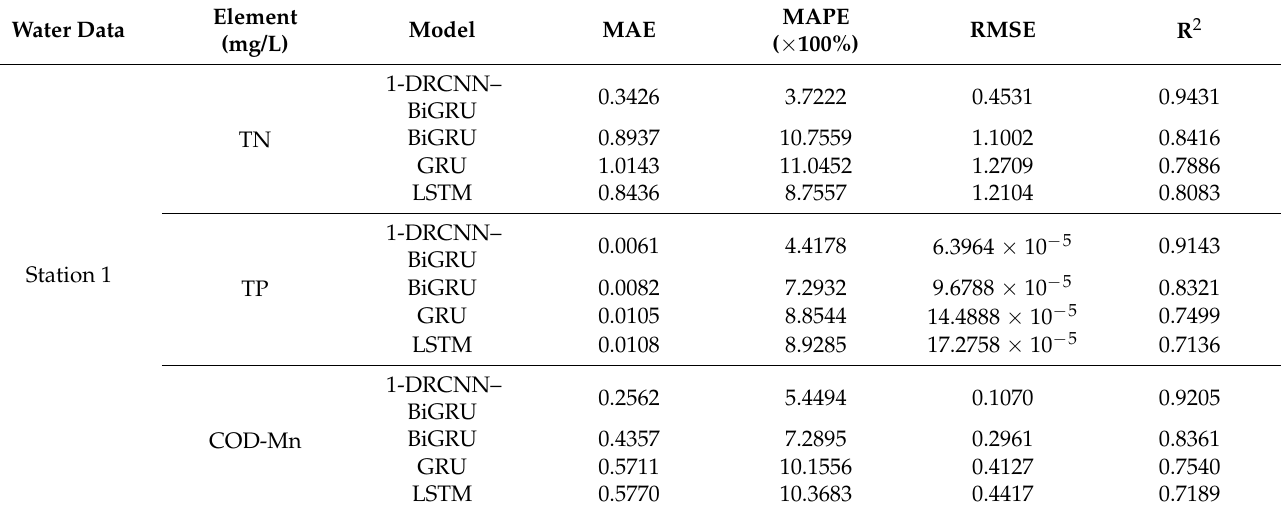
Table 3. Comparison between the proposed model and other models on station 1. Water